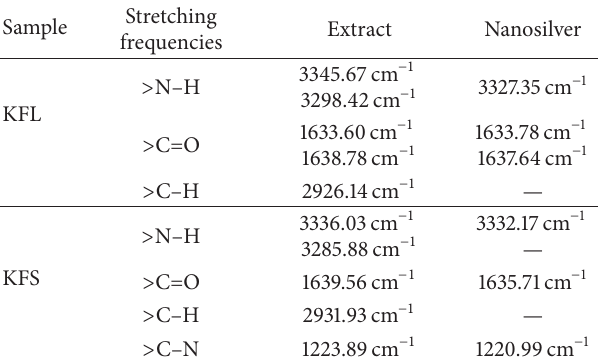
Table 2: Frequency values of FTIR peaks for KFL and KFS extracts and synthesized